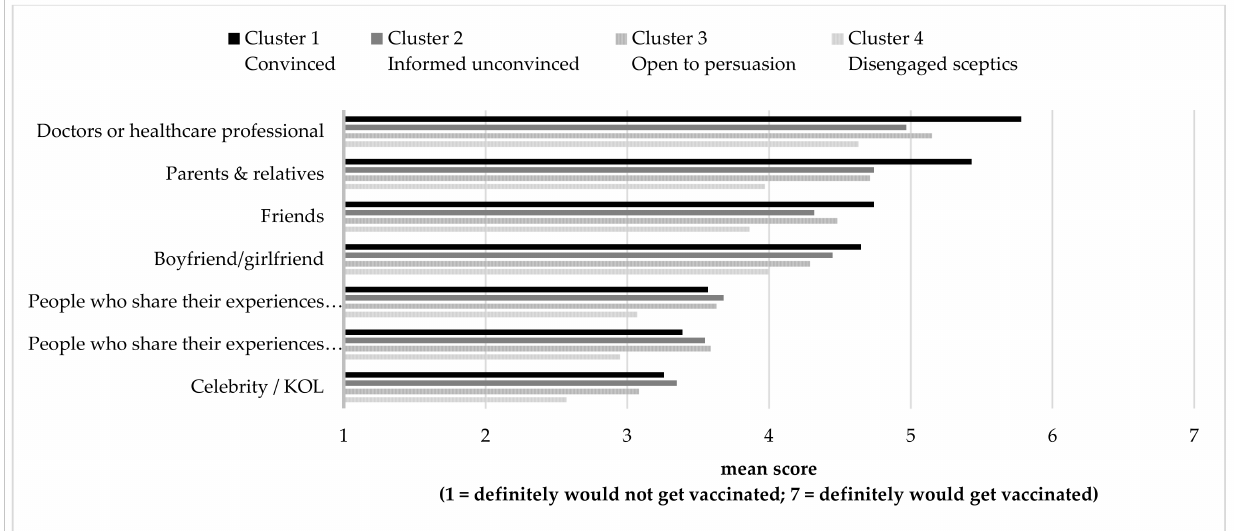
Figure 3. Claimed effectiveness of influencer in motivating seasonal influenza by